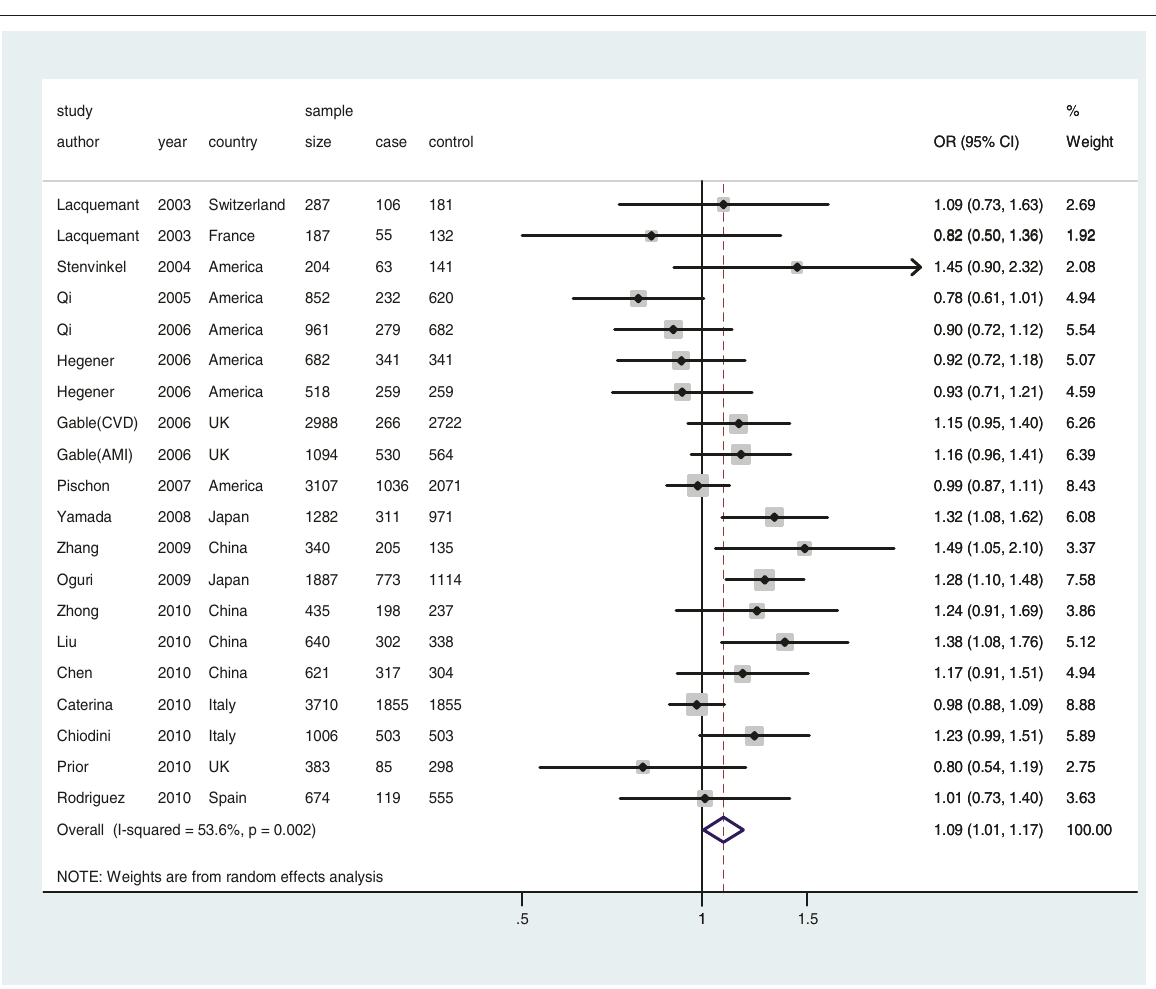
Figure 4 Meta-analysis for the relationship between rs266729 and CVD risk . Year represents publish year. The solid squares represent odds ratios (ORs) from individual studies; the diamonds are shown as overall effect. The combined ORs along with their 95% CIs were in the contrast of G allele vs. C allele and estimated using the random-effects